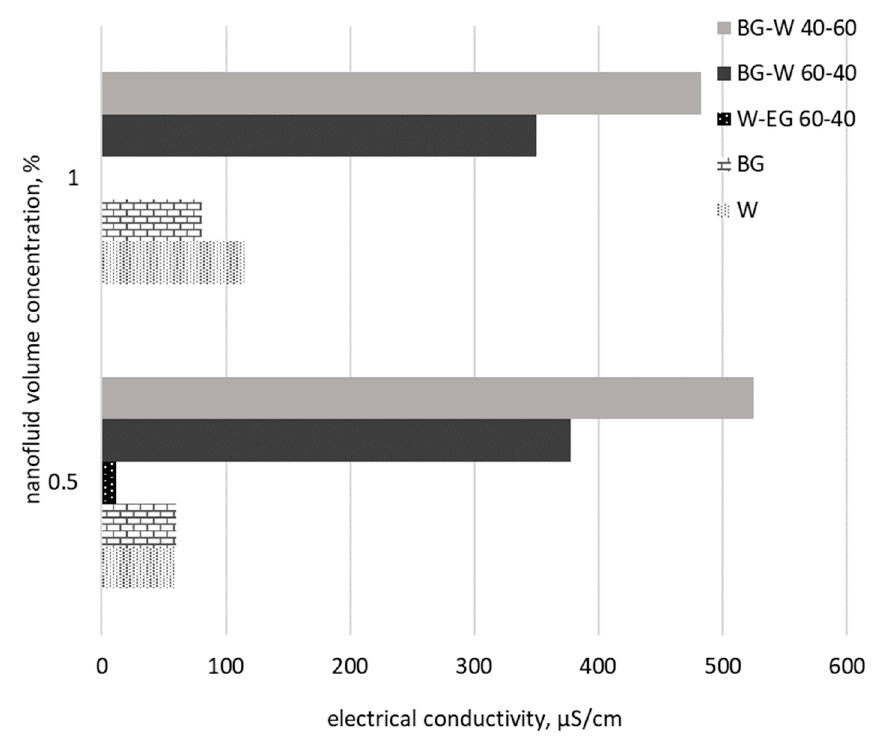
ff erent base fluids